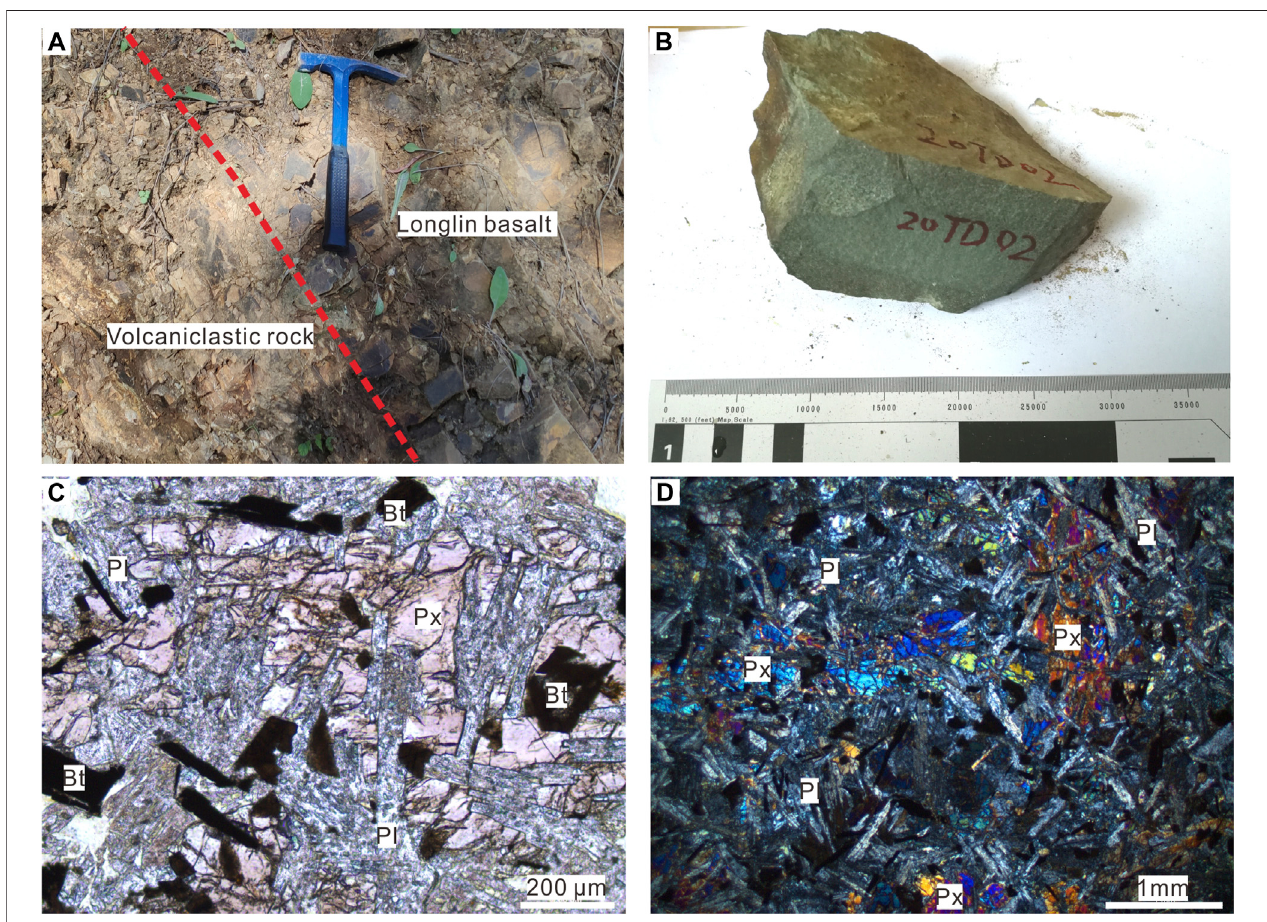
FIGURE 3 | Photos of (A) fi eld outcrop, (B) hand-specimen, and (C – D) thin-section microscopy (c: PPL, d: XPL) of the Longlin basalts.